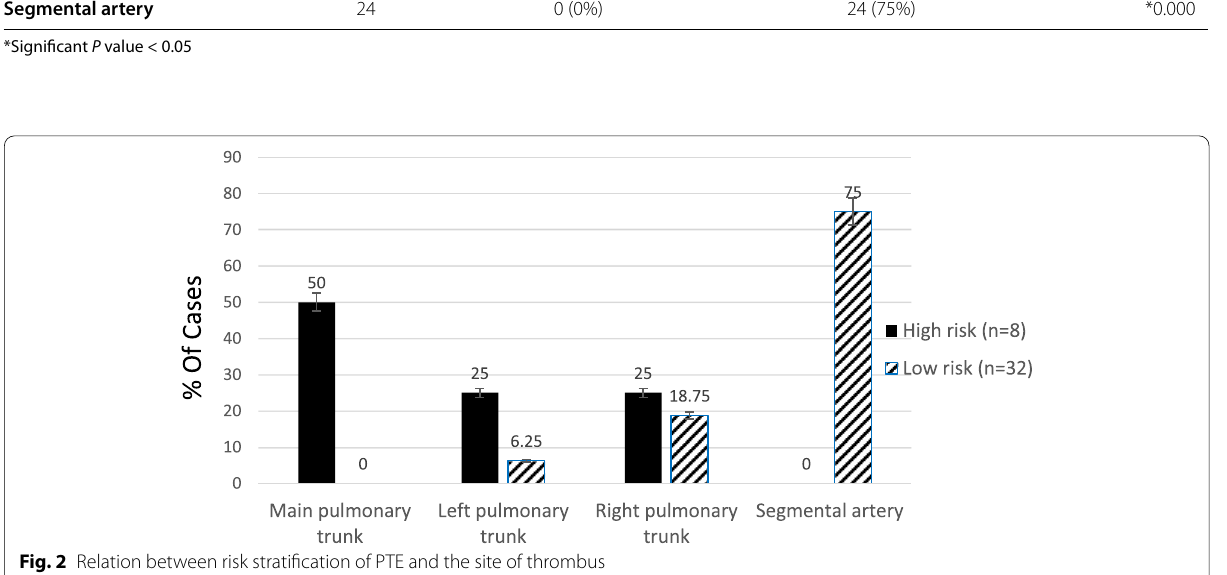
*Significant P value < 0.05